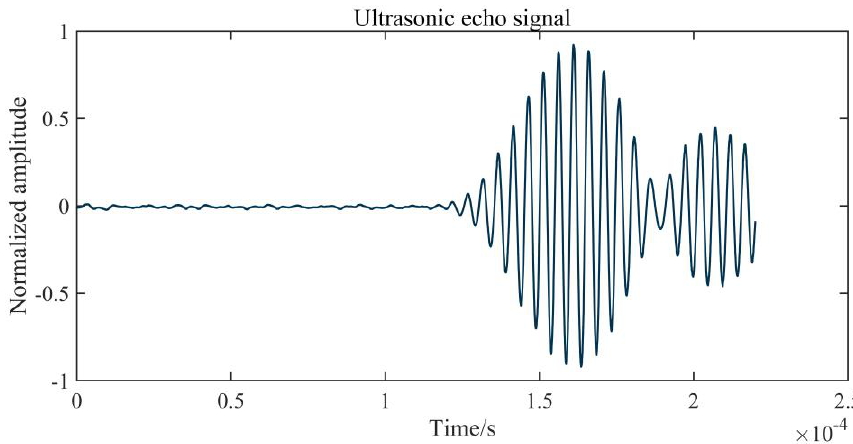
Figure 1. A typical ultrasonic echo signal.